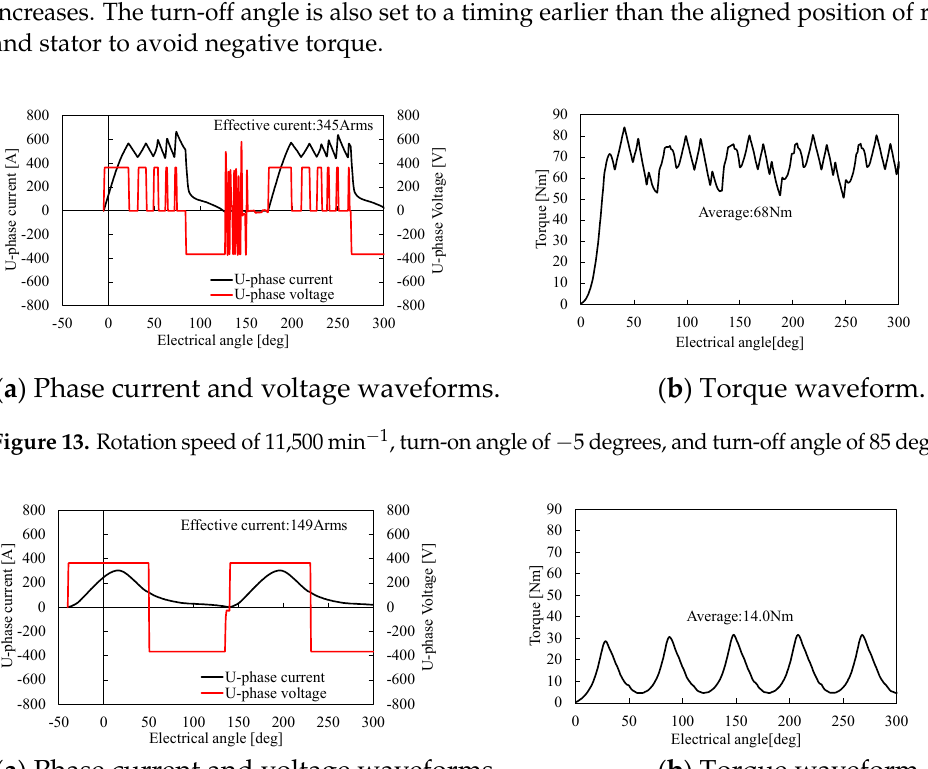
Figure 13. Rotation speed of 11,500 min -1 , turn-on angle of − 5 degrees, and turn-off angle of 85 degrees.